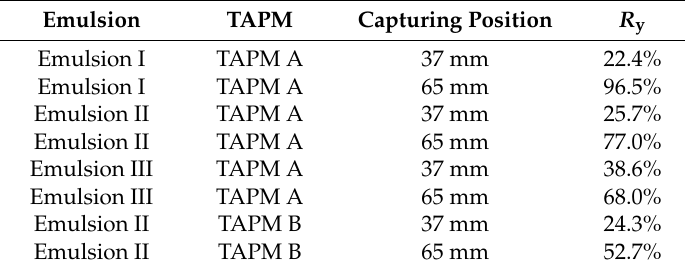
Table 3. Fractions ( R y ) of yellow area of oil phase in the total area of photomicrographs captured in Figure 5. Emulsion